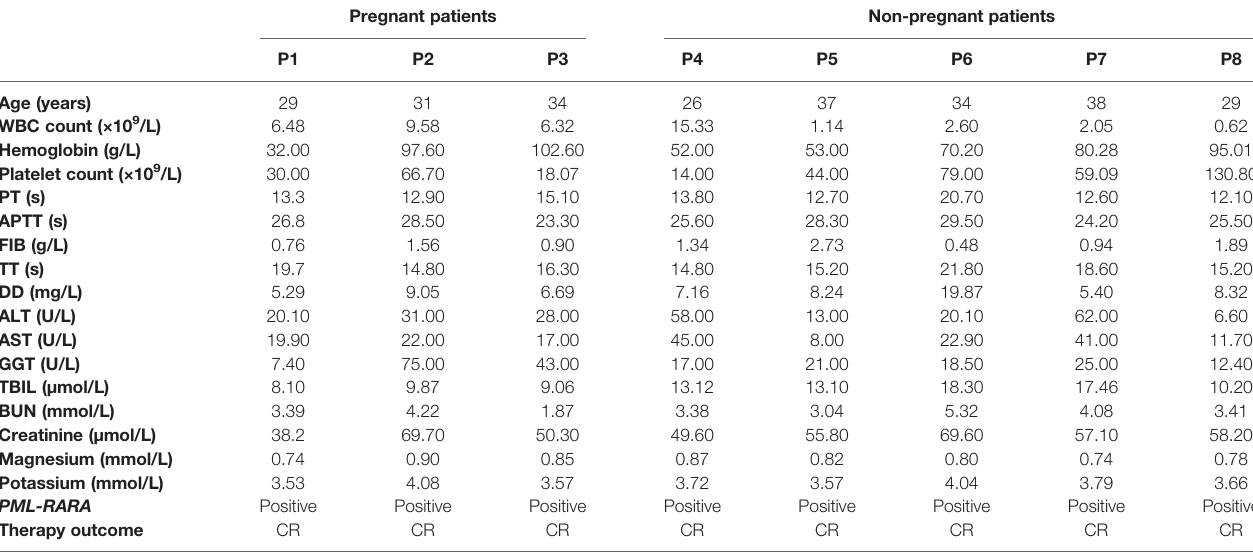
TABLE 1 | Baseline characteristics and therapy outcome of patients in this